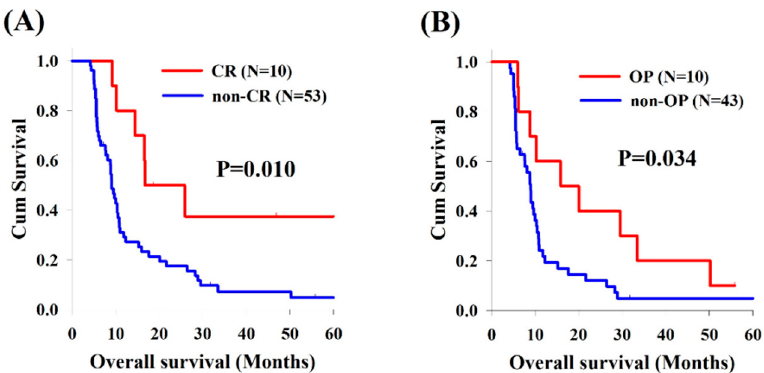
Figure 4. Kaplan–Meier survival curves of overall survival among patients with thoracic esophageal squamous cell carcinoma: ( A ) CR group versus non-CR group; and ( B ) OP versus non-OP in the non-CR group. CR, complete response; OP, operation.